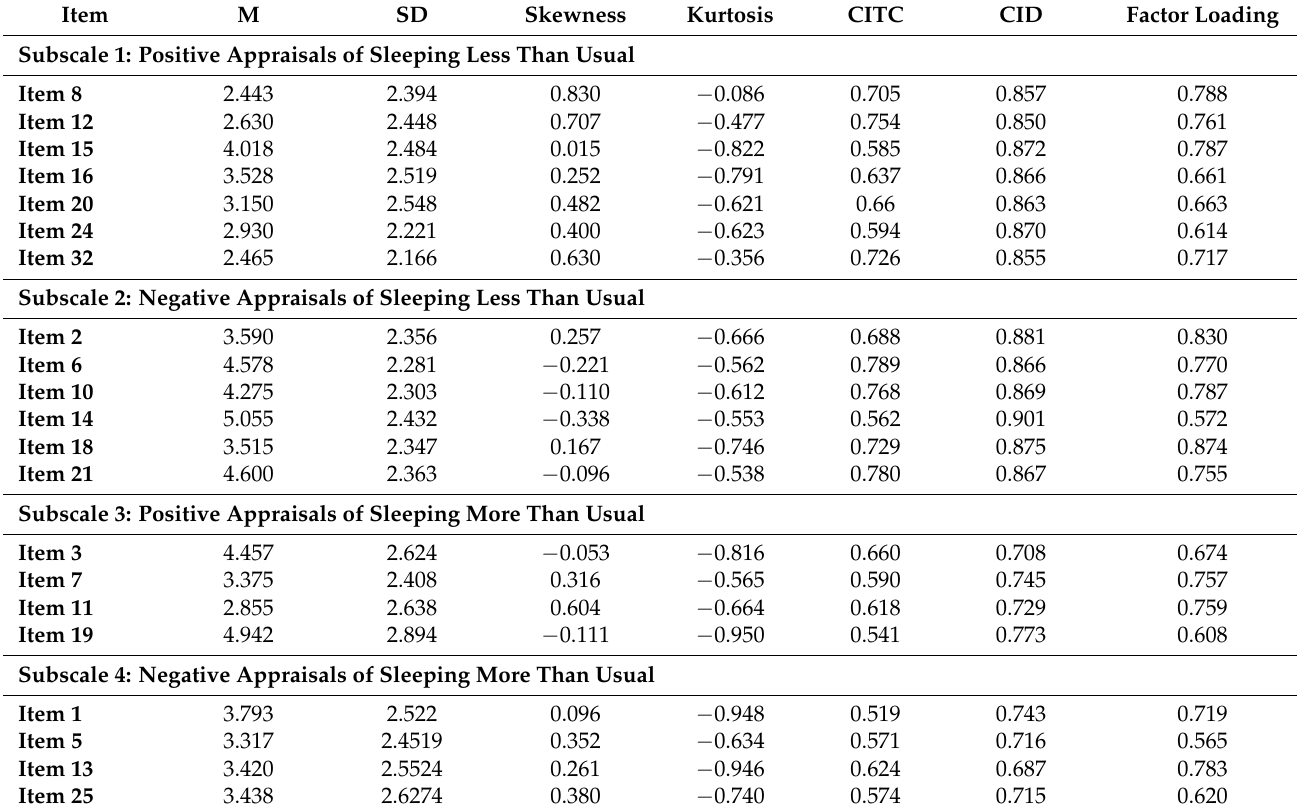
Table 2. Item properties of the PANSAM scale among the general population.